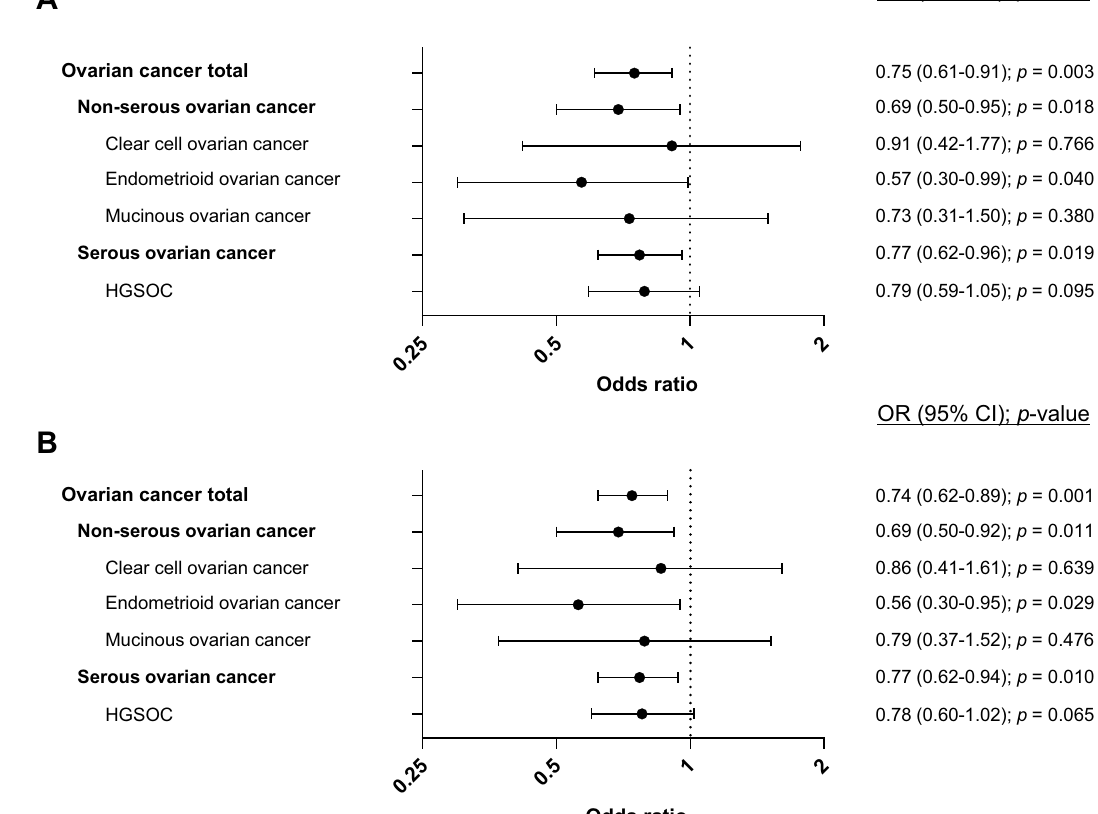
Figure 1. APOBEC3A/B deletion and ovarian cancer risk. Forest plots illustrating odds ratios (ORs) with 95% confidence intervals (CI) for ovarian cancer and subtypes, related to the APOBEC3A/B deletion variant, applying A) the dominant model and B) the allele